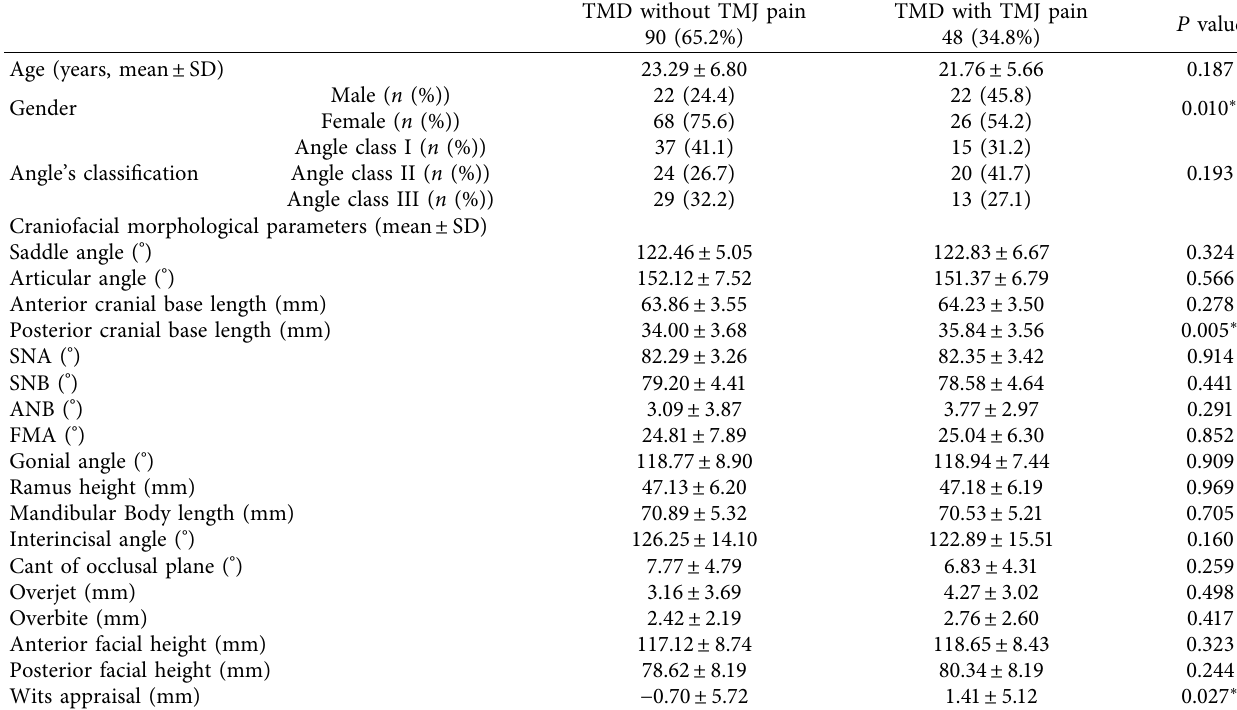
Table 6: Comparison of demographic, occlusal, and craniofacial morphological characteristics between TMD patients with and without TMJ pain.